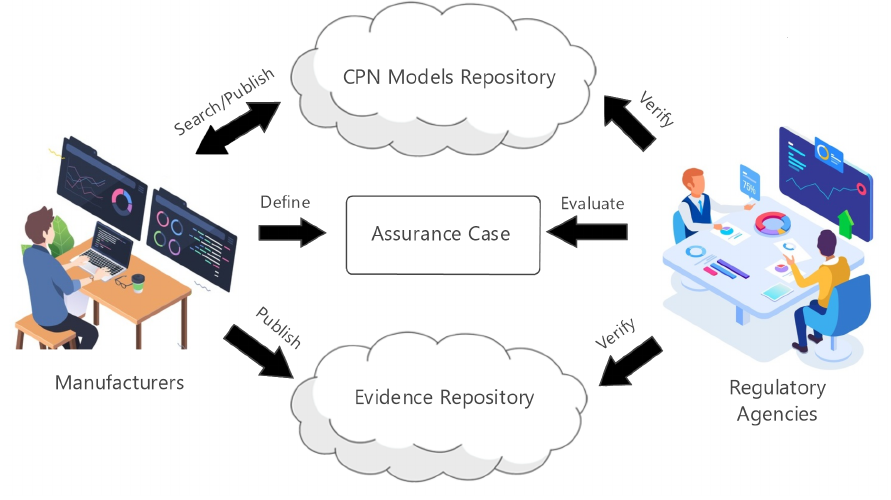
Figure 3. Relationship between manufacturer and regulatory agency.